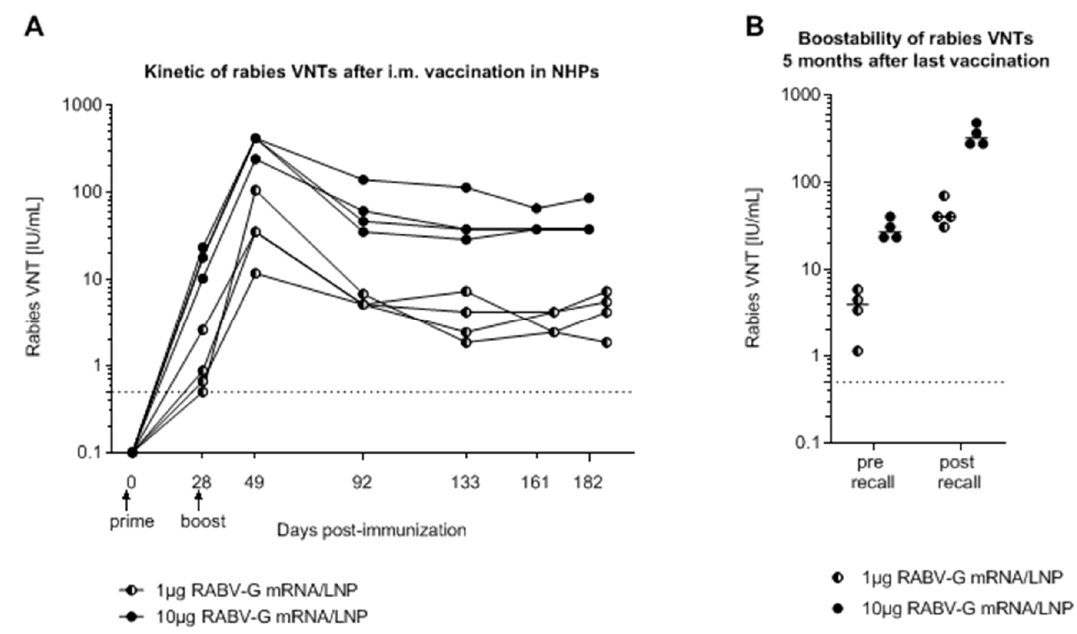
Figure 5. Kinetics of the serum neutralizing antibody responses to mRNA LNP formulations in nonhuman primates (NHPs) (adapted from reference [41]). ( A ) Rabies virus neutralizing antibody titers (VNTs) in individual cynomolgus monkeys (NHP) after two intramuscular doses of 1 or 10 μ g mRNA LNP given 28 days apart. ( B ) Five months after the primary doses, VNTs were measured again before and after receiving a booster dose of the respective vaccine. The dashed line shows WHO protective value (0.5 IU/mL). Lipid nanoparticle (LNP)-formulated mRNA was generated using LNPs provided by Acuitas Therapeutics (Canada).